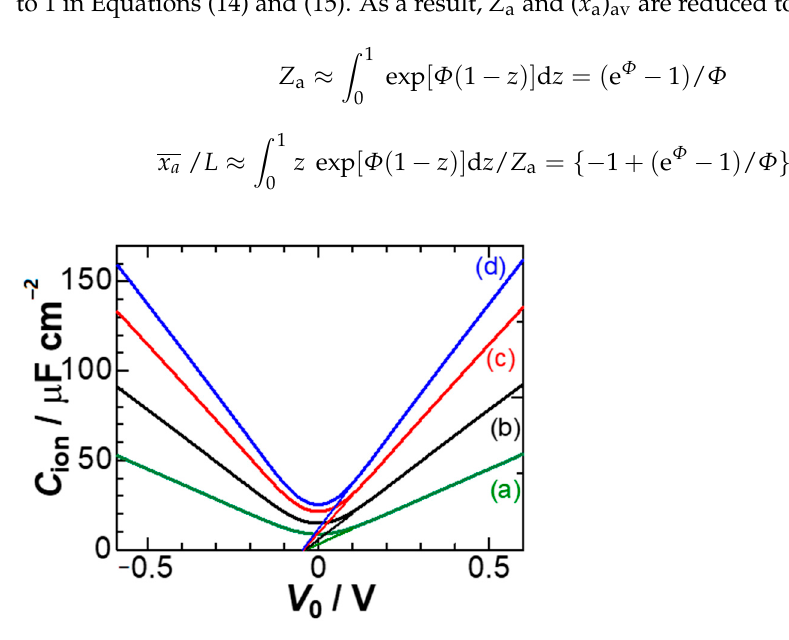
Figure 8. Variations of C ion with V 0 calculated from Equations (16), (17) and (19) for c = ( a ) 0.2 M, ( b ) 1 M, ( c ) 3 M and ( d ) 5 M at ε r = 78, T = 298 K. ( b ) 1 M, ( c ) 3 M and ( d ) 5 M at ε r = 78, T = 298